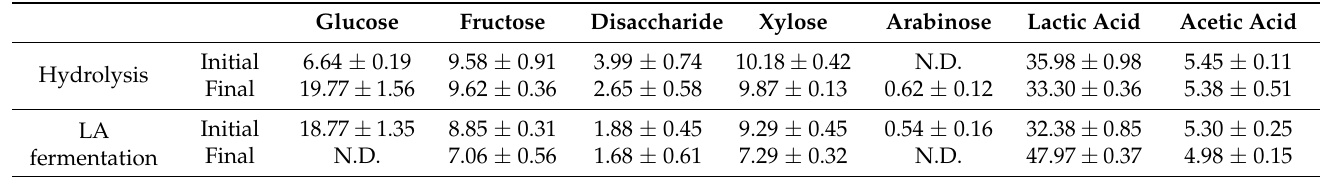
Table 2. The average concentration of sugars, lactic and acetic acid obtained by hydrolysis and fermentation from OFMSW using WBE (g/L).